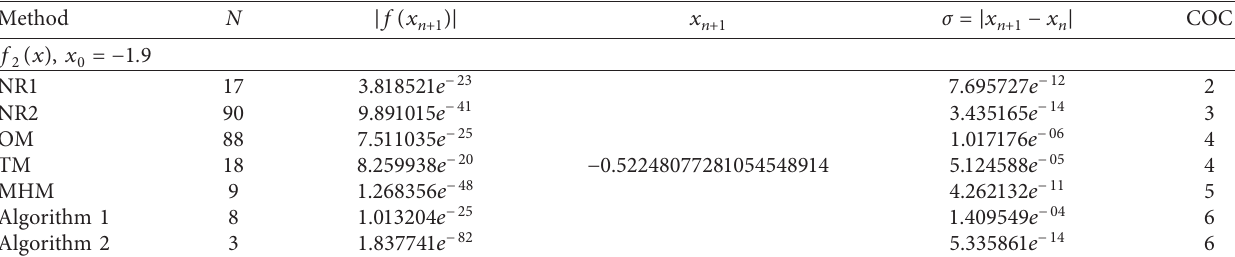
Table 2: Comparison of various iterative methods.